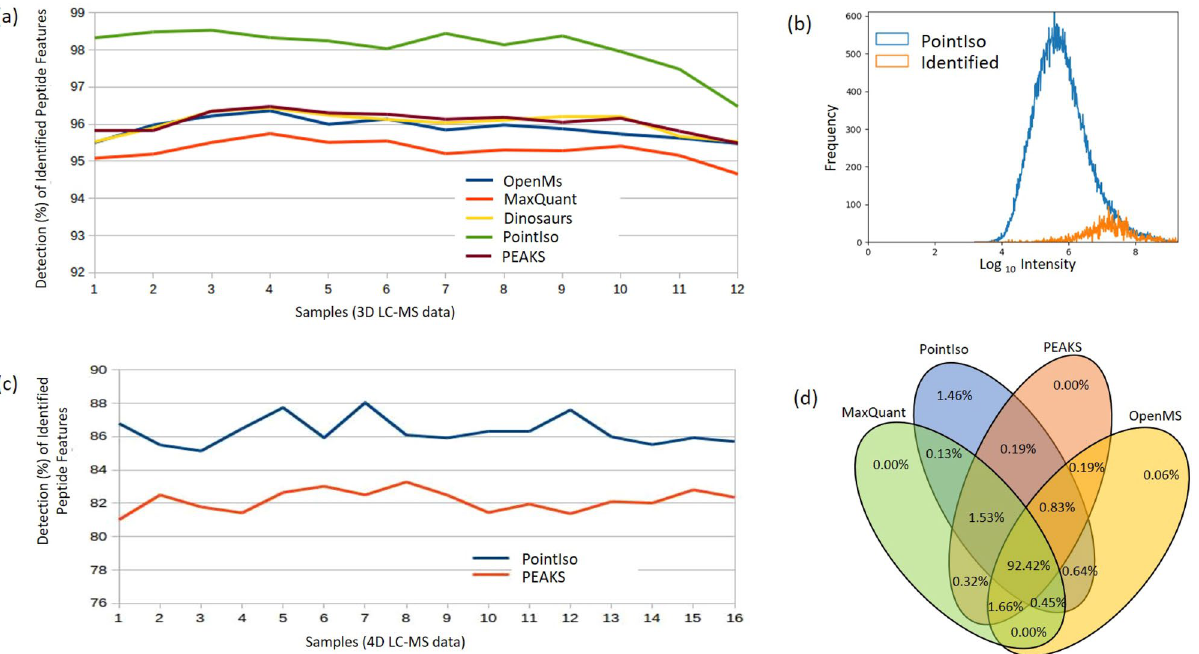
Figure 2. ( a ) Detection percentage of identified peptide features by different tools for 12 samples, each having different concentrations. ( b ) The intensity distribution of peptide features detected by PointIso (blue) and identified by database search (orange). We see that the distribution of identified features is wedged into the high- intensity tail of the distribution of detected peptide features because only high-intensity features are selected for fragmentation. ( c ) Detection percentage of identified 4D peptide features by PEAKS and PointIso for 16 samples generated by TimsTOF instrument (sample 1–12 belong to phase A and sample 13–16 belong to phase B). ( d ) Venn diagram of identified peptide features detected by different algorithms (we show four algorithms to keep the Venn diagram simple). We see that there are about 1.46% peptide features which are detected exclusively by PointIso. In the Supplementary Fig. S4 we show the type of features which are missed by other feature detection tools.